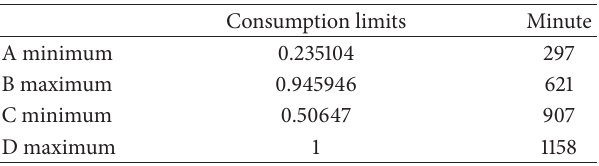
Table 3: Limit values of the representative curve in the precrisis